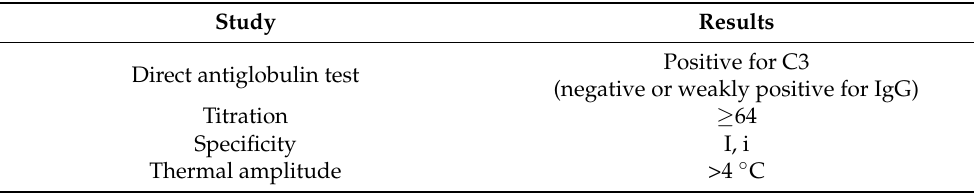
Table 3. Immunohematologic study when CAD is